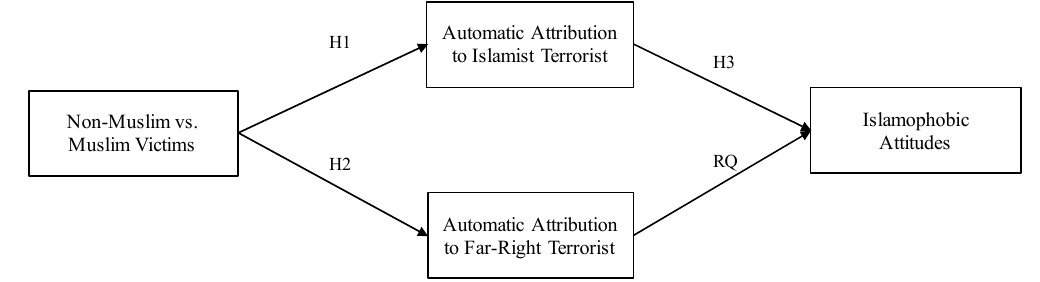
Figure 1. Hypothesized Theoretical Figure 1 . Hypothesized Theoretical Model .